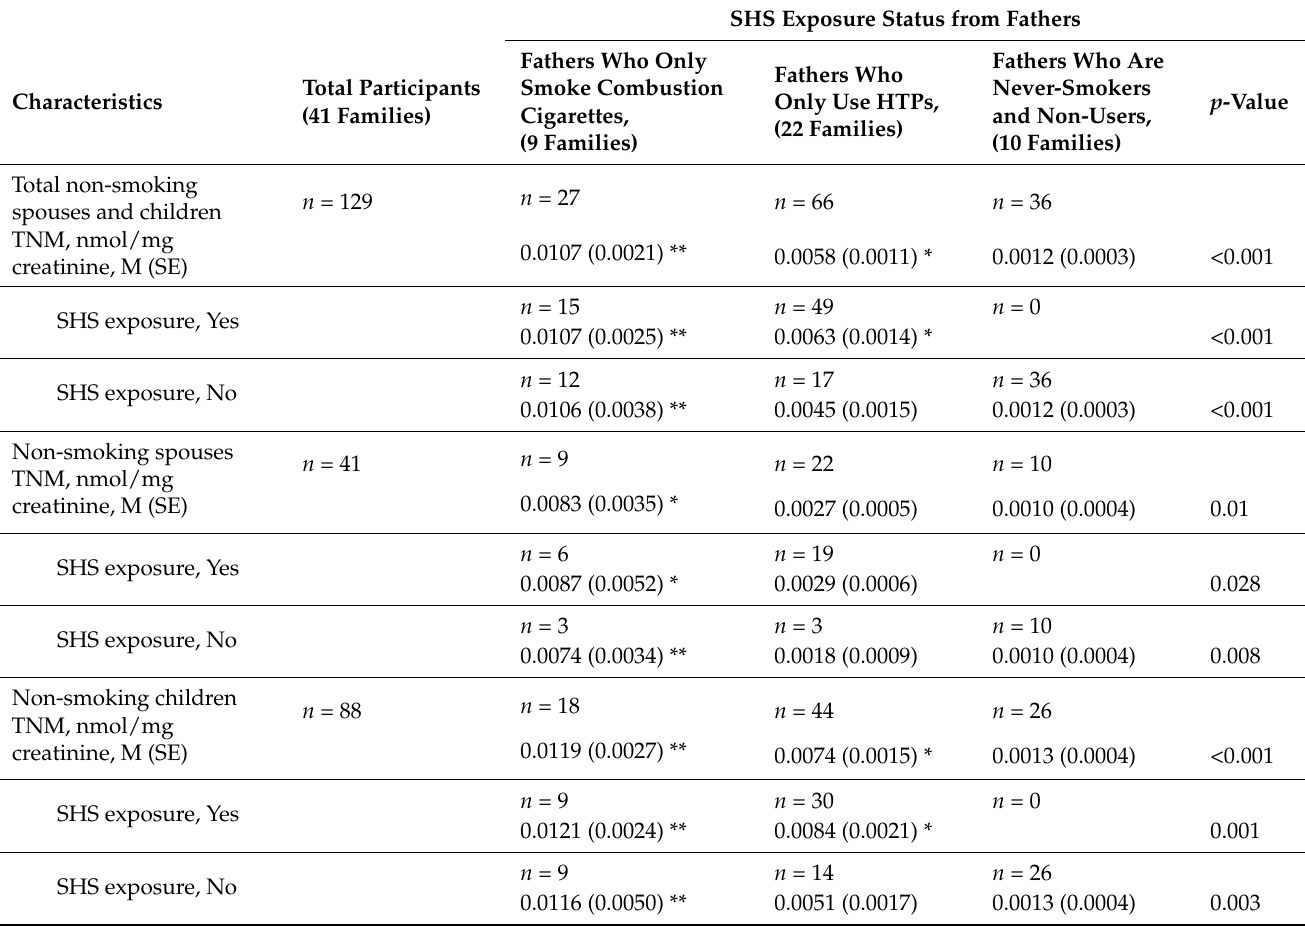
Table 3. The urinary levels of TNMs after creatine normalization according to the SHS exposure status from